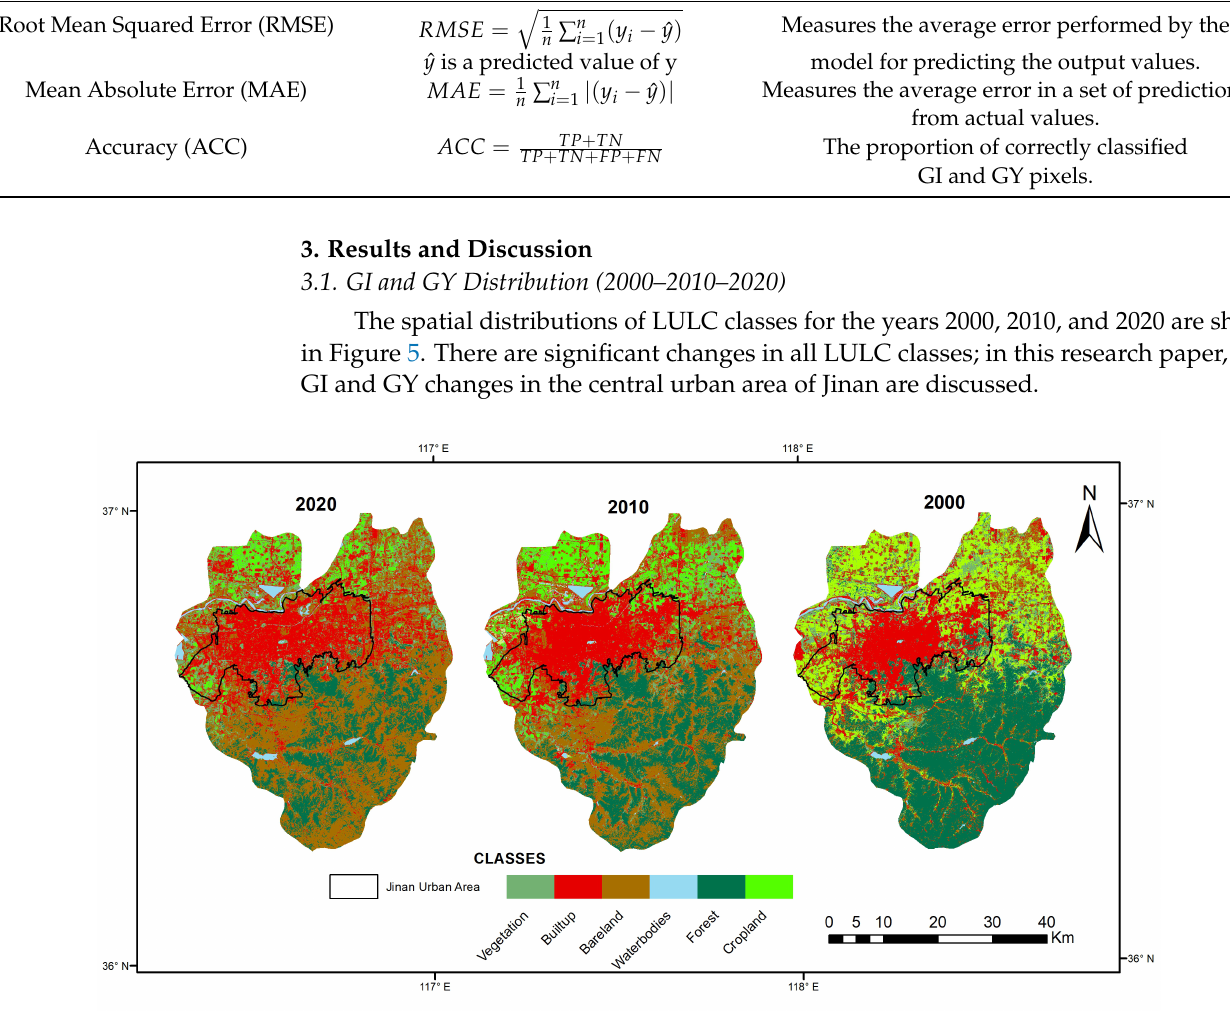
Figure 5. Classified LULC maps of Jinan for year 2000, 2010, and